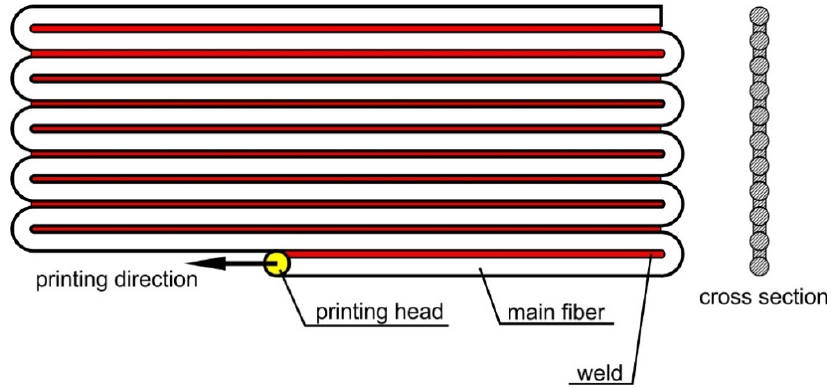
Figure 1. Diagram of the structure of a single layer made using the 3D printing technique.